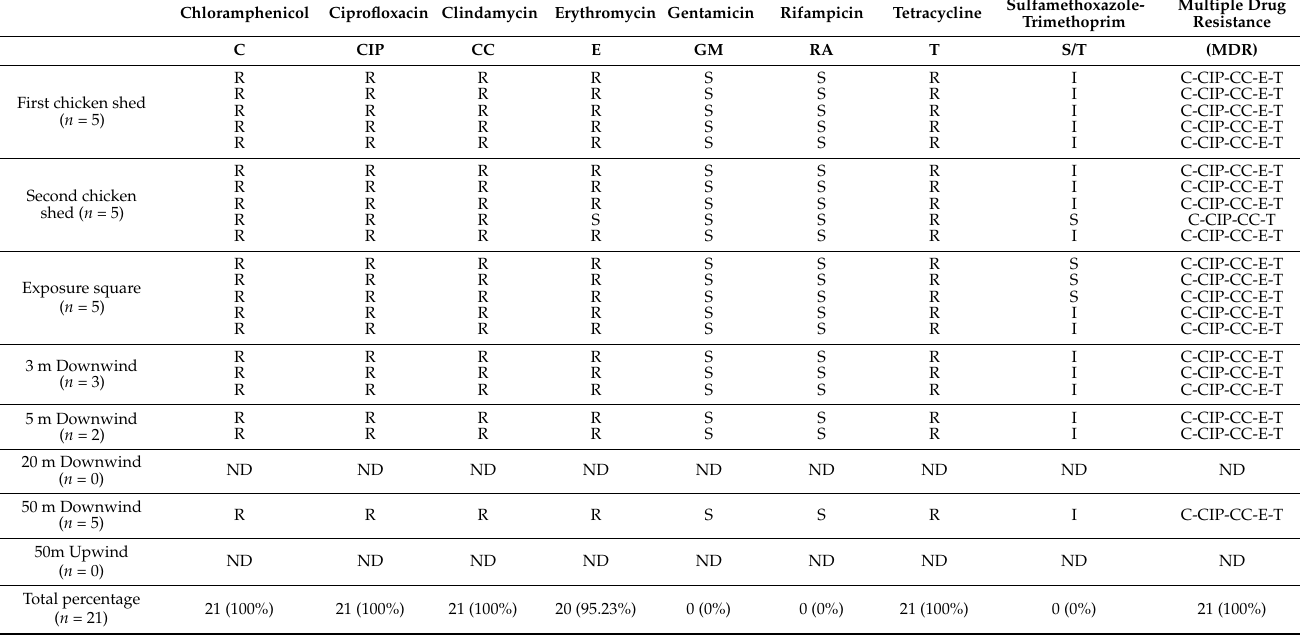
Table 5. The value of zone of inhibition diameter measurements and multiple drug resistance categorization of MRSA